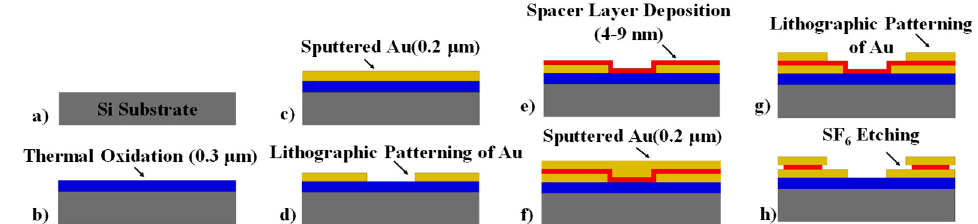
Figure 3. Simplified fabrication process of vertical nanogap electrodes separated by a thin spacer layer. ( a ) 4” Si wafer, ( b ) Thermally grown 300 nm SiO 2 , ( c ) Deposit 200 nm Au bottom electrode and ( d ) pattern lithographically, ( e ) Deposit spacer layer, ( f ) Deposit 200 nm top Au electrode and ( g ) pattern, ( h ) SF 6 dry etch to form nanogap.